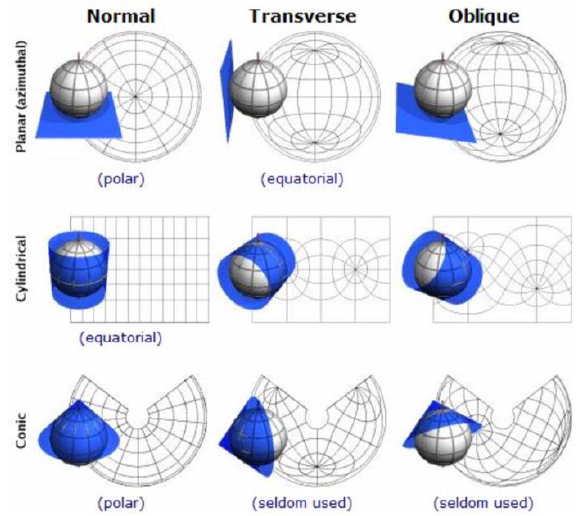
Figure 13. Map Projections with Different Geometric and Orientation of Projection Surface. (Source: Map Projections - Basic Definitions and Concepts, Carlos Alberto Furuti, 2012)